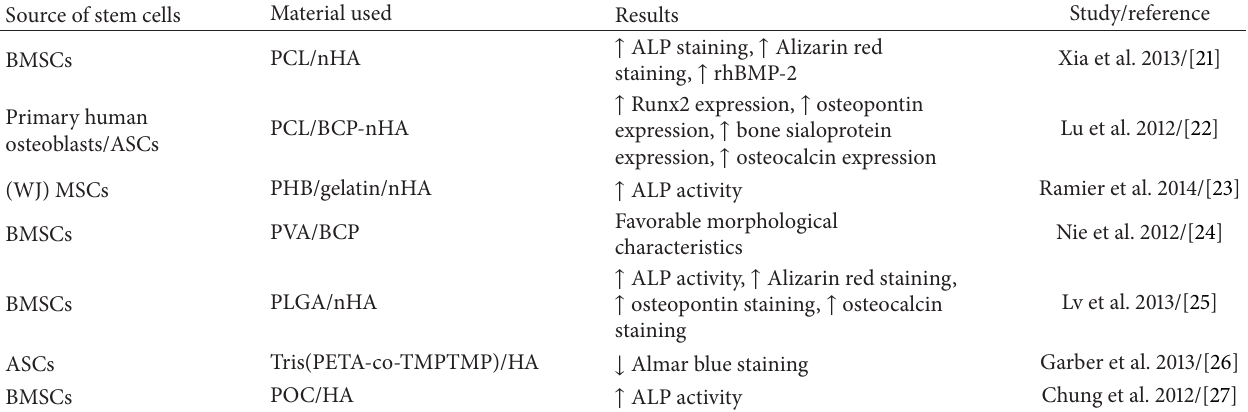
Table 2: Summary of references for synthetic materials in combination with